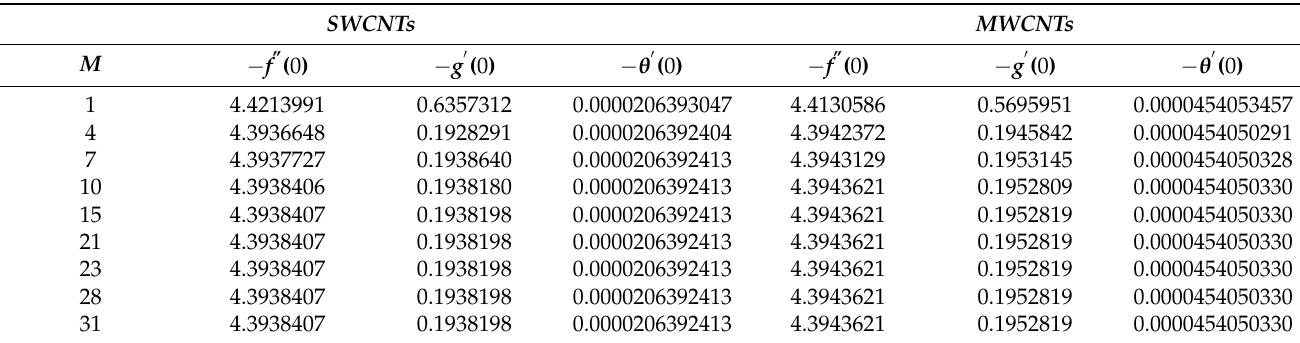
Table 4. Convergence of the proposed method when φ = 0.2, Re = 0.9, γ 1 = 0.4, γ 2 = 0.5,